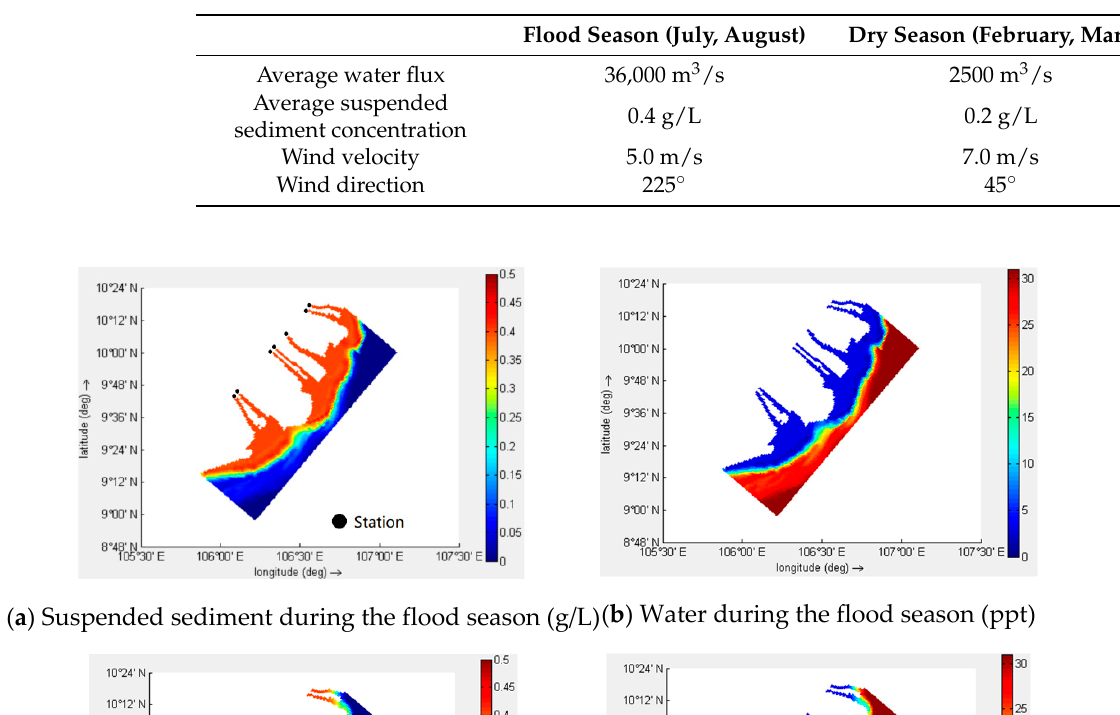
Table 1. Average values of water, sediment fluxes and wind velocity in the Mekong River during the flood and dry season in 2018.